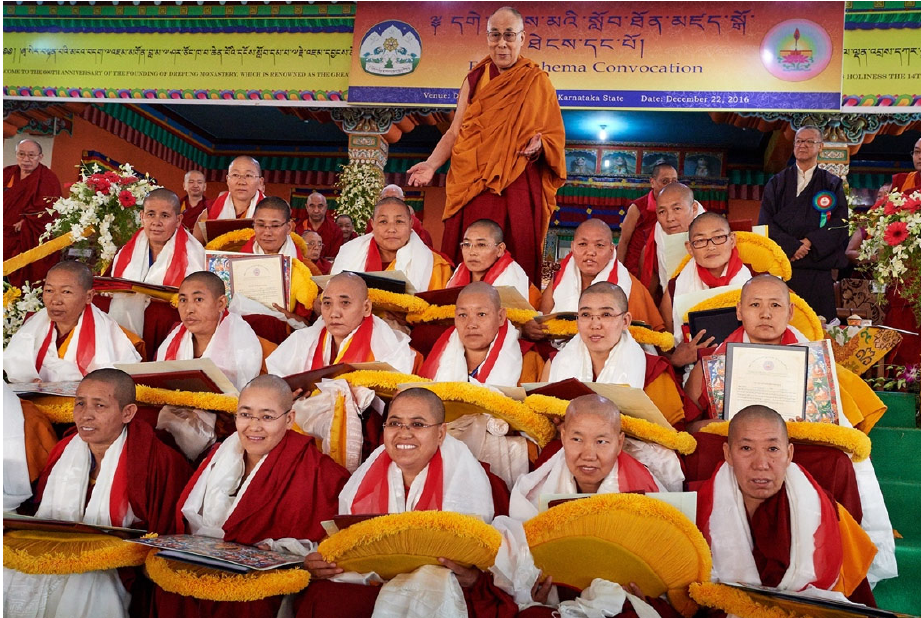
Figure 4. The graduation ceremony of the first group of geshema s (Photo courtesy Olivier Adam).